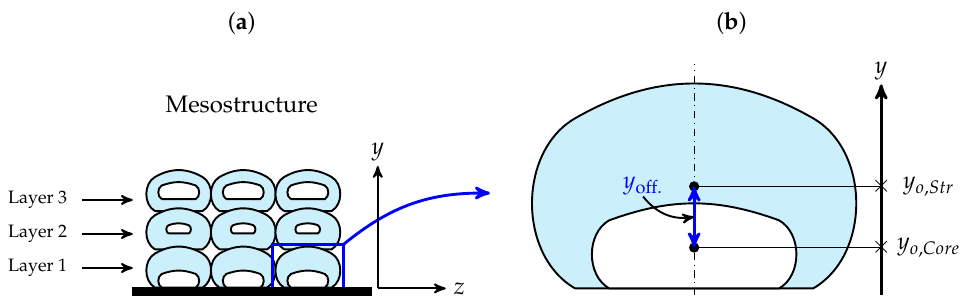
Figure 2. Schematic illustration of the cross-section of ( a ) a 3D-printed mesostructured with three layers, and ( b ) the vertical offset between the centre of the core and the centre of the